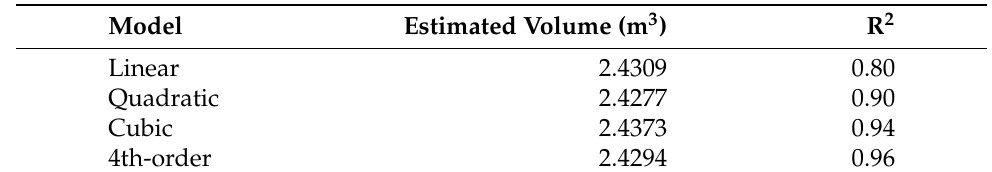
Table A1. Polynomial model summary.